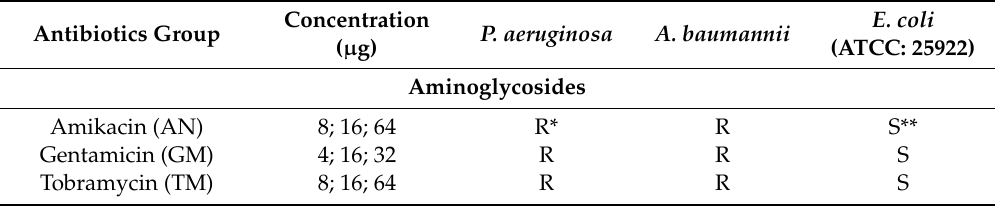
Table 1. The antimicrobial-resistant pattern of selected multidrug-resistant